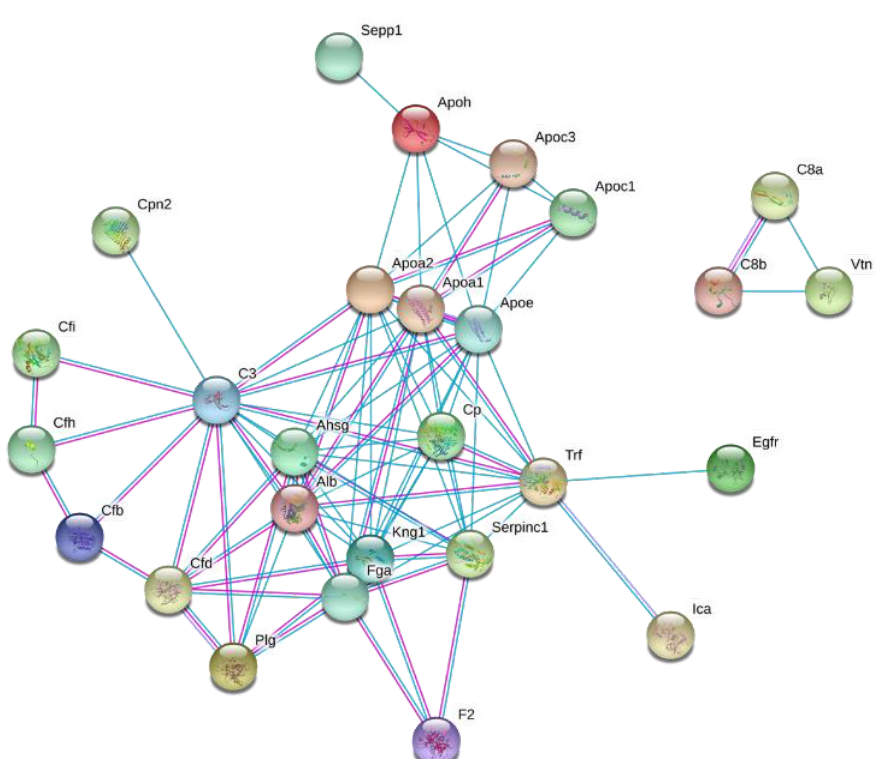
Figure 5. Interaction network of proteins with HFD-induced altered turnover rates. The identified proteins with altered turnover rates were analyzed using the STRING database [41].